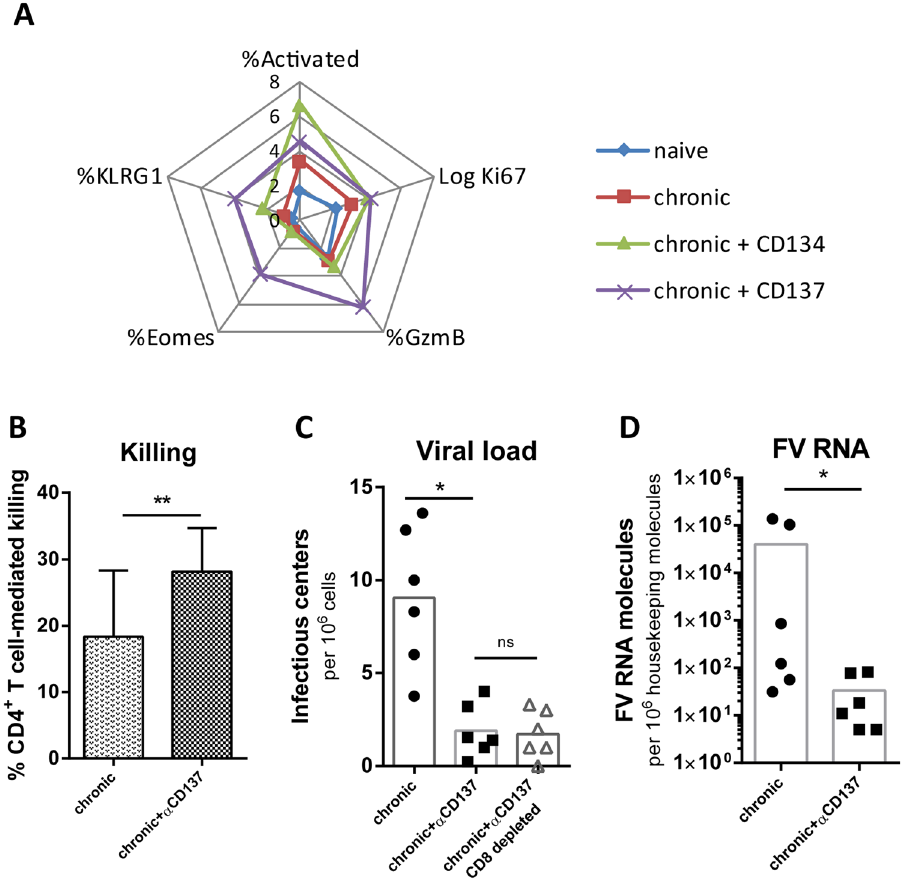
Figure 6. Effector cell profile of CD4 + T cells following costimulatory therapy. To augment CD4 + T cell cytotoxicity FV-infected mice were treated with α CD134 or α CD137 antibodies as described in Materials and Methods. ( A ) Spider plot analysis showing the expression levels of CD4 + T cell activation, differentiation and cytotoxic markers after antibody therapy. α CD134 antibody treatment only enhanced activation of CD4 + T cells, but only α CD137 antibodies induce expression of molecules associated with a cytotoxic program. ( B ) The percentage of the target cell killing in the lymph nodes of FV-infected mice following α CD137 antibody treatment. Mice receiving an isotype control antibody did not show any difference to the non-treated control group. ( C ) Viral loads in FV-infected mice after CD137 treatment. ( D ) FV RNA levels after CD137 treatment. Statistically significant differences between the groups were determined by the unpaired t test: * p < 0.05; ** p < 0.005; *** ns, not